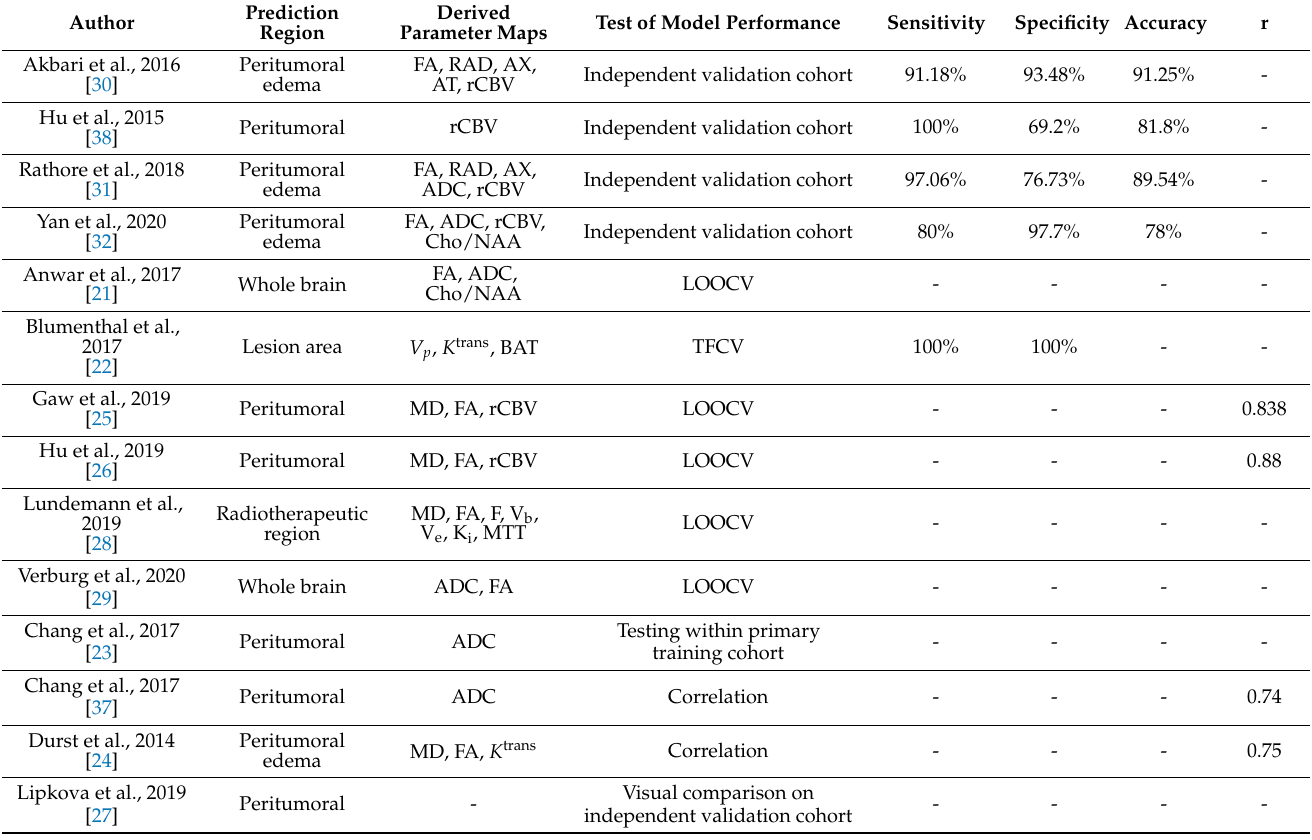
Table A1. Supplementary extracted data, not crucial to the main